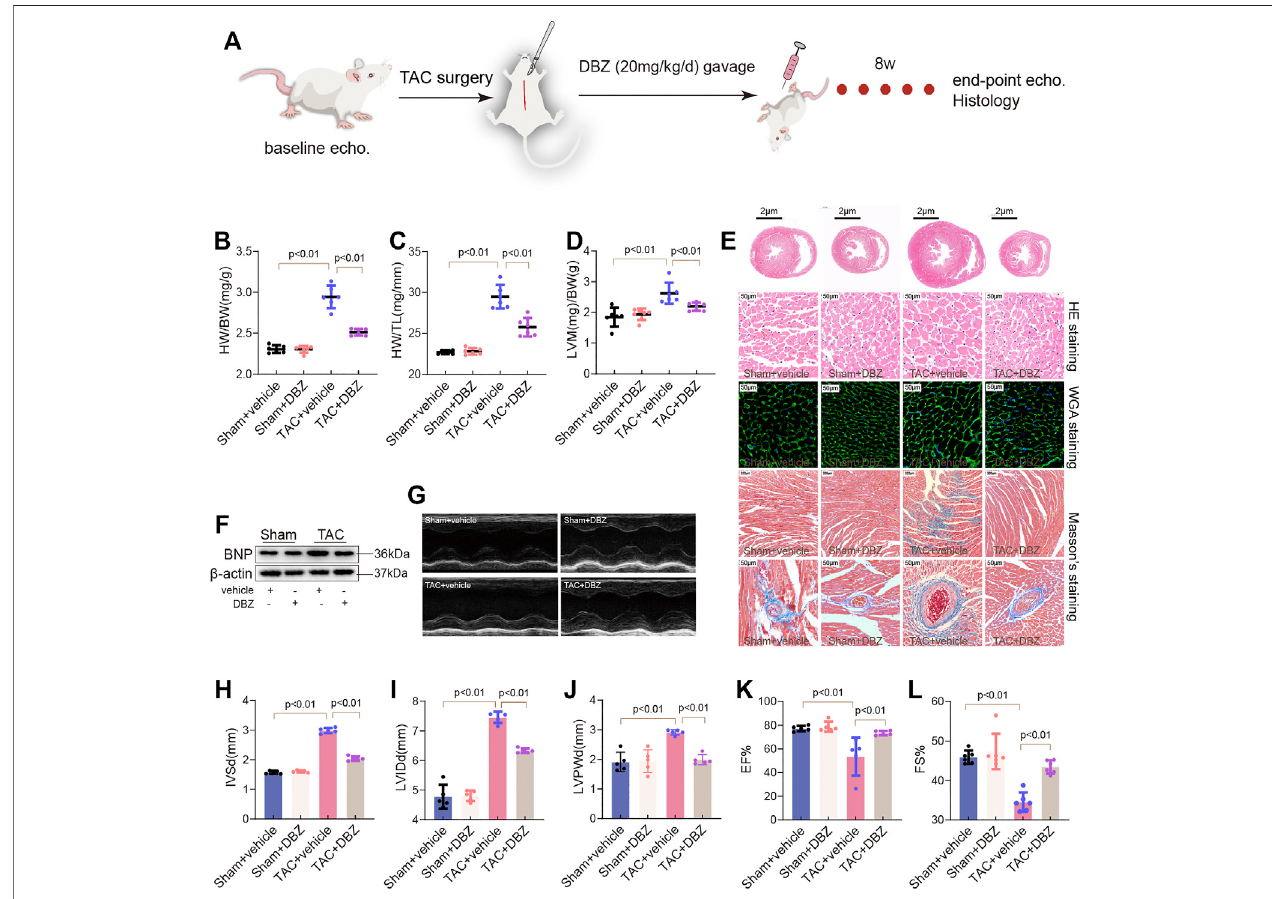
FIGURE 1 | DBZ improves cardiac function and attenuates cardiac remodeling in TAC-induced cardiac hypertrophy. (A) Flowchart of study protocol. (B – D) The ratiosofheartweight/bodyweight,heartweight/tibialength,andleftventricularmass/bodyweightofrats( n =10)inthe8thweek. (E) Representativetransversesections of H&E staining ( fi rst row; scale bar = 2 μ m), Macroscopic view of H&E staining (second row; scale bar = 50 μ m), WGA staining (third row; scale bar = 50 μ m) and Masson ’ sstaining(fourthand fi fthrow;scalebar=200and50 μ m)fromhearttransversesections. n =4 – 6. (F) RepresentativeimagesofWesternblottingassayof BNP. (G – L) Representative M-mode images of the four groups and quanti fi cation of interventricular septum diastolic dimension (IVSd), LV internal dimension diastole (LVIDd), and LV posterior wall thickness diastole (LVPWd), ejection fraction (EF) and fractional shortening (FS). n = 6. Results are expressed as means ± SD. Statistical analyses were performed by one-way ANOVA followed by Bonferroni ’ s post-hoc